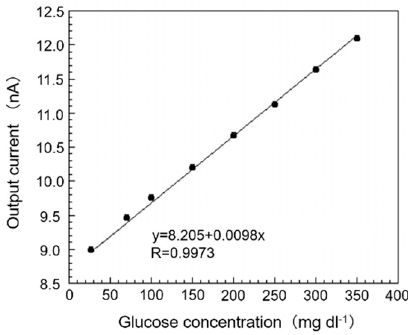
Figure 5. The calibration curve of the proposed biosensor in EISF. The assay conditions were as follows: temperature 30 °C. Each sample was measured 10 min after the output current became stable.